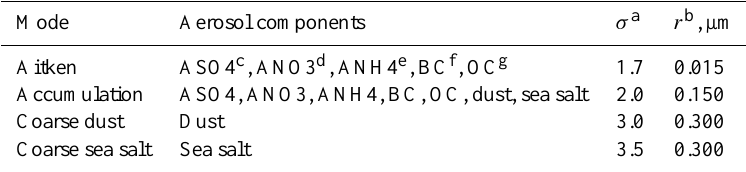
Table 1. Aerosol size distribution parameters in RAMS-CMAQ. Mode Aerosol components